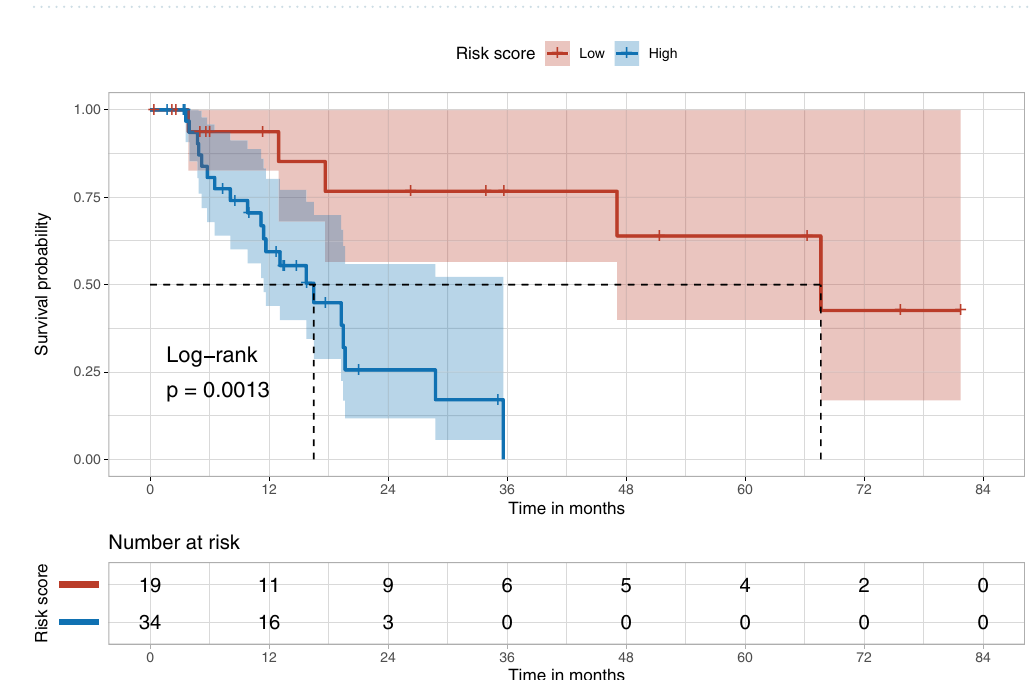
Figure 5. Kaplan–Meier plots for the high- and low-risk subgroups in the internal (TCGA-HCC) test set. The Kaplan–Meier plot shows the difference in the survival distributions for the low- and high-risk subgroups, stratified based on the risk scores predicted by HCC-SurvNet on the internal test set (log-rank p value =